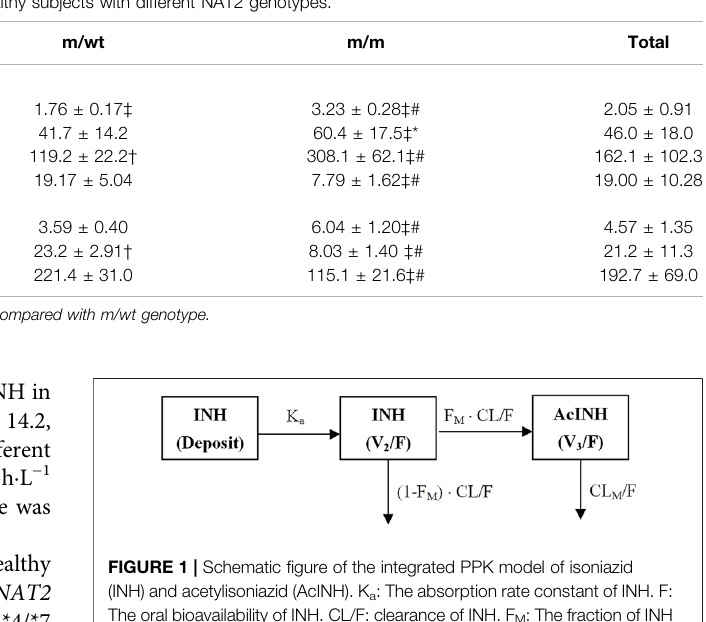
BUN, blood urea nitrogen; TBIL, total bilirubin; ALT, alanine aminotransferase; AST, glutamic-oxaloacetic transaminase.